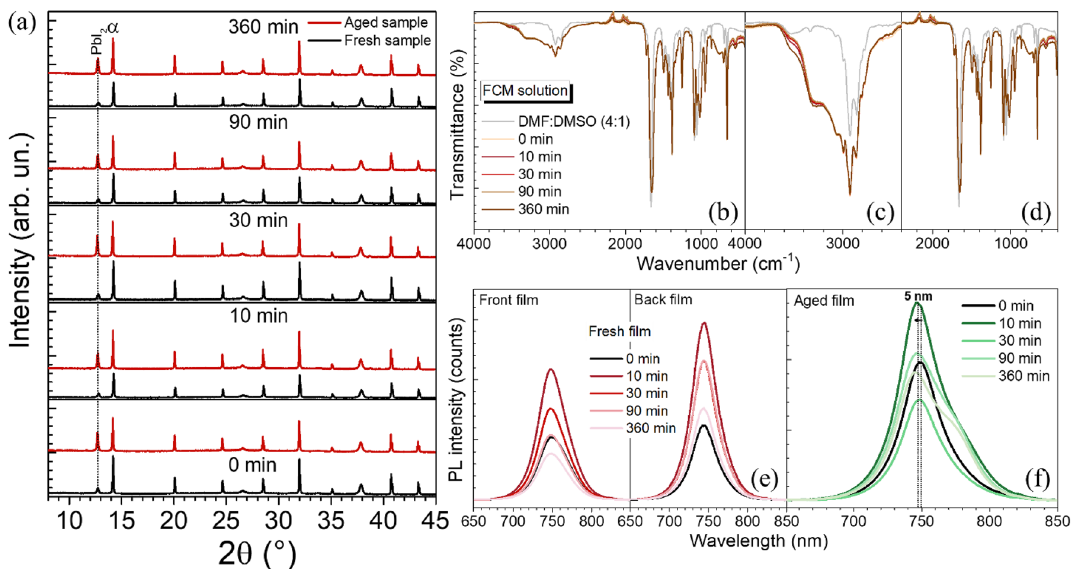
Figure 4. ( a ) Effective idle time duration testing after illumination (30 min under 1 sun) by keeping the solution under dark condition at different time durations of 0, 10, 30, 90, and 360 min, respectively. These solutions were used for fabricating 6 perovskite thin films, each of which was measured by XRD at 0 day (fresh, black line) and 30 days (aged, red line). Weekly XRD results are shown in Fig. S6. (110) is the perovskite characteristic peak labelled as ⍺ . ( b ) FTIR spectra ( c ) Zoom-in FTIR spectra in the range of wavenumber 4000–2400 cm -1 and ( d ) 2400–400 cm -1 , respectively. PL emission spectra of ( e ) fresh films and ( f ) aged